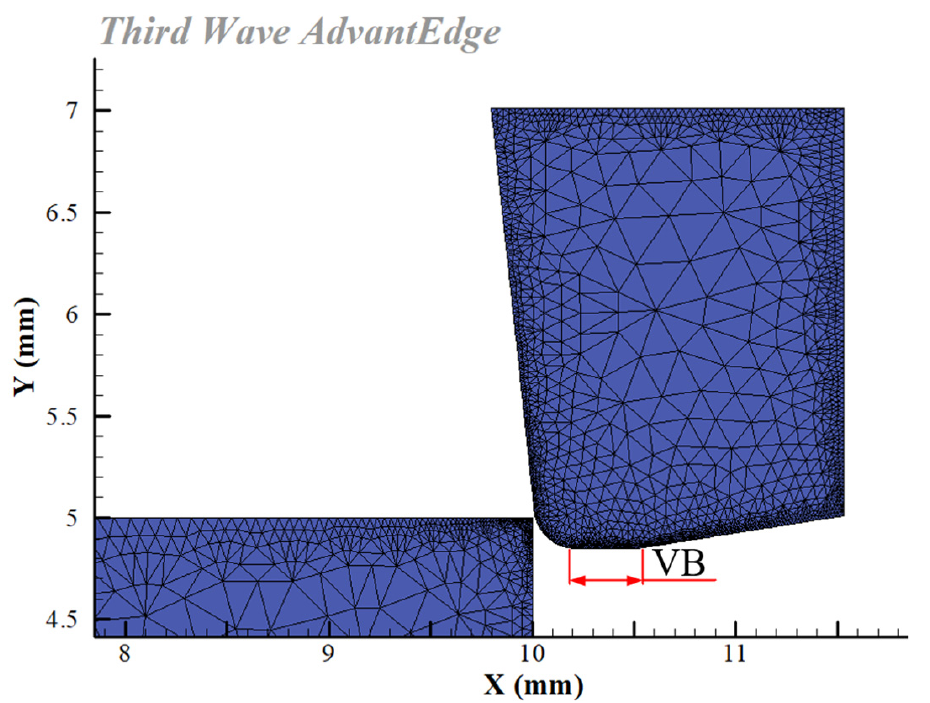
Figure 1. Workpiece–tool parameter settings: ( a ) standard workpiece; ( b ) standard tool. Table 1. Simulation parameters.